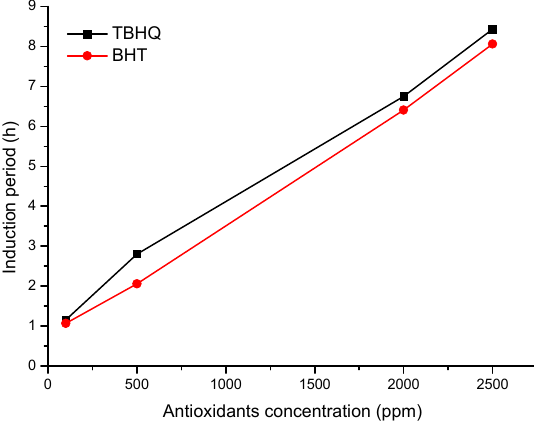
Figure 8. Effect of concentrations of TBHQ and BHT in the induction period of methyl biodiesel of B. glabra .